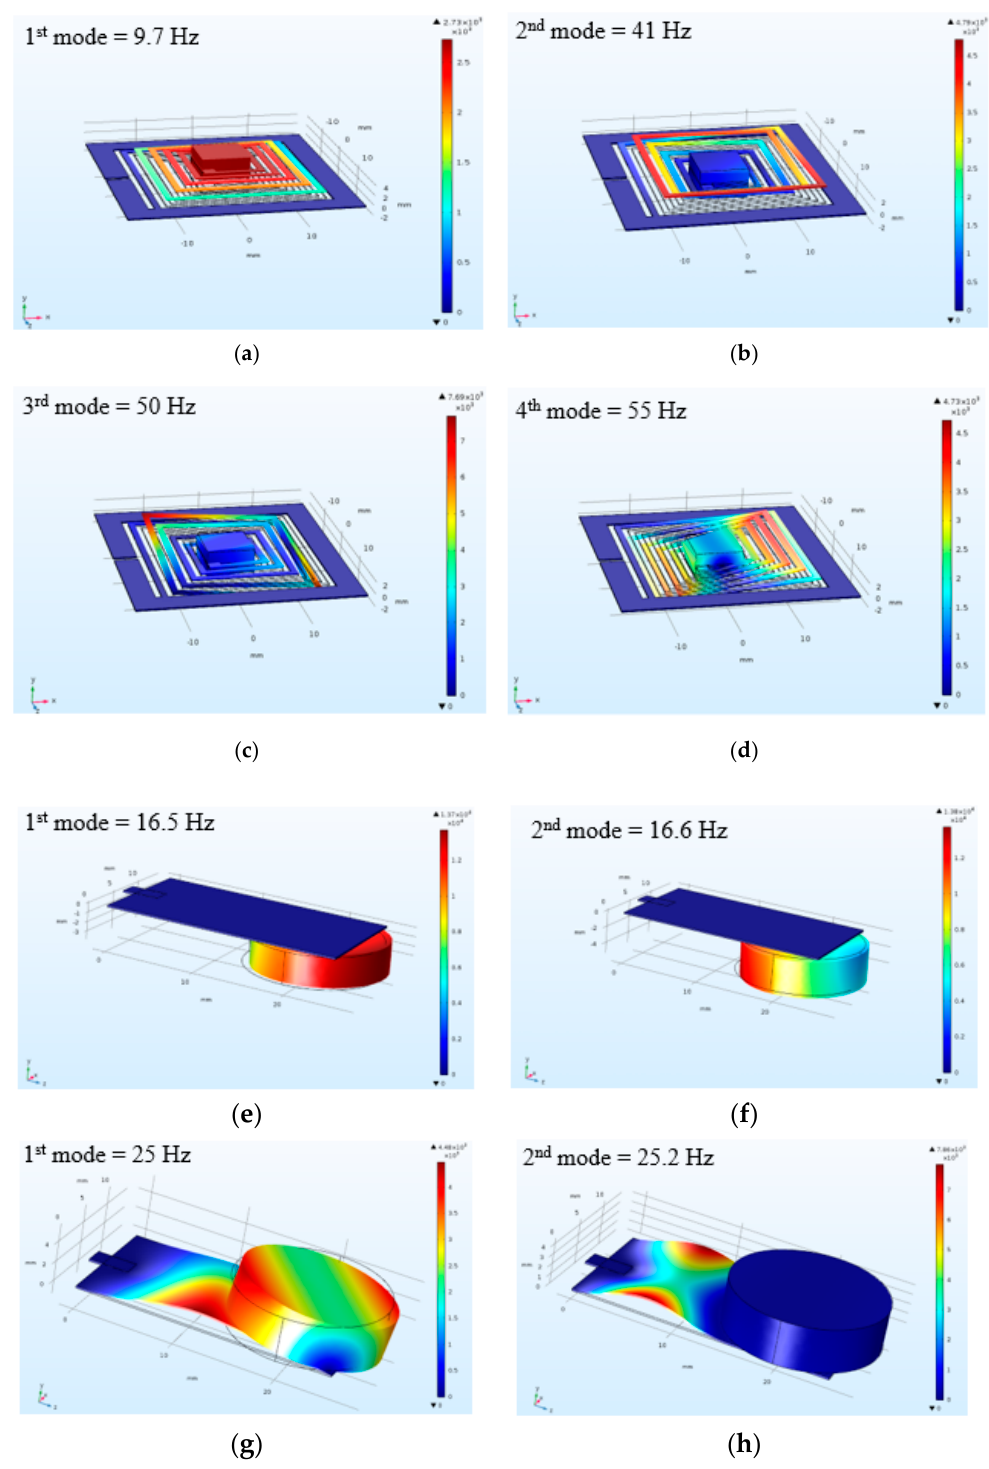
Figure 2. Eigen frequency analysis of spiral spring holding magnets: ( a ) 1st resonance at 9.7 Hz; ( b ) 2nd resonance at 41 Hz; ( c ) 3rd resonance at 50 Hz; ( d ) 4th mode at 55 Hz; ( e ) 1st mode of Polyvinylidene fluoride (PVDF-I) at 16.5 Hz; ( f ) 2nd mode of PVDF-I at 16.6 Hz; ( g ) 1st mode of PVDF-II at 25 Hz; ( h ) 2nd mode of PVDF-II at 25.1 Hz.